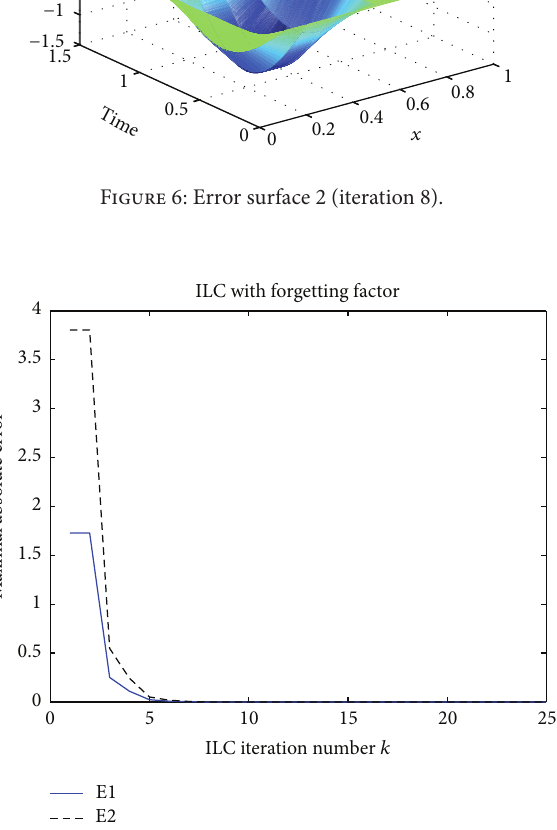
Figure 7: Iterations-maximum error